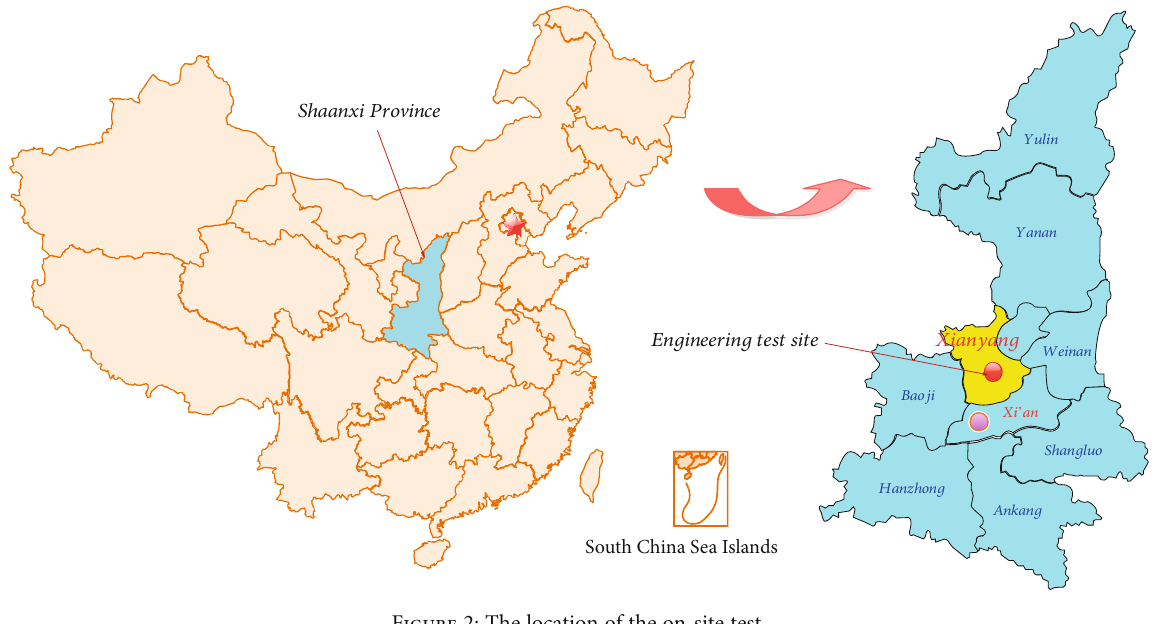
Figure 2: The location of the on-site test. Table 1: Coal industry analysis and coal quality test results.